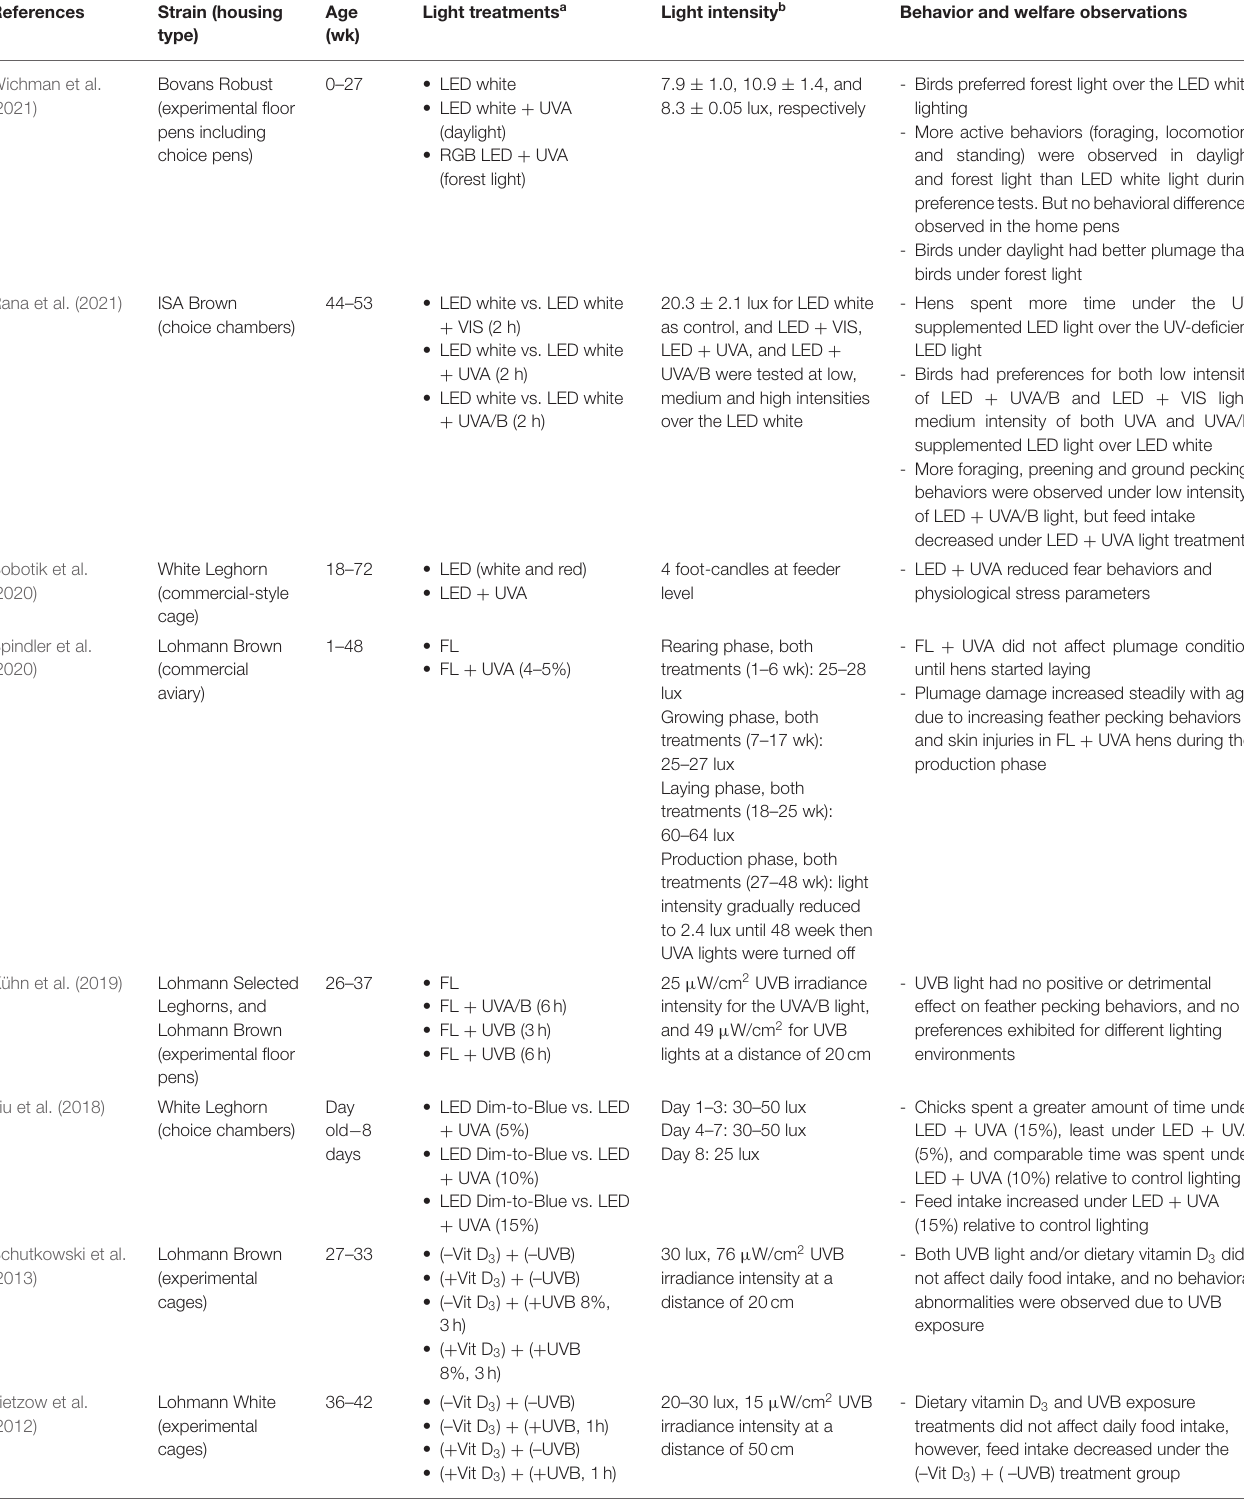
TABLE 1 | Effects of UV light on laying hen behavior and